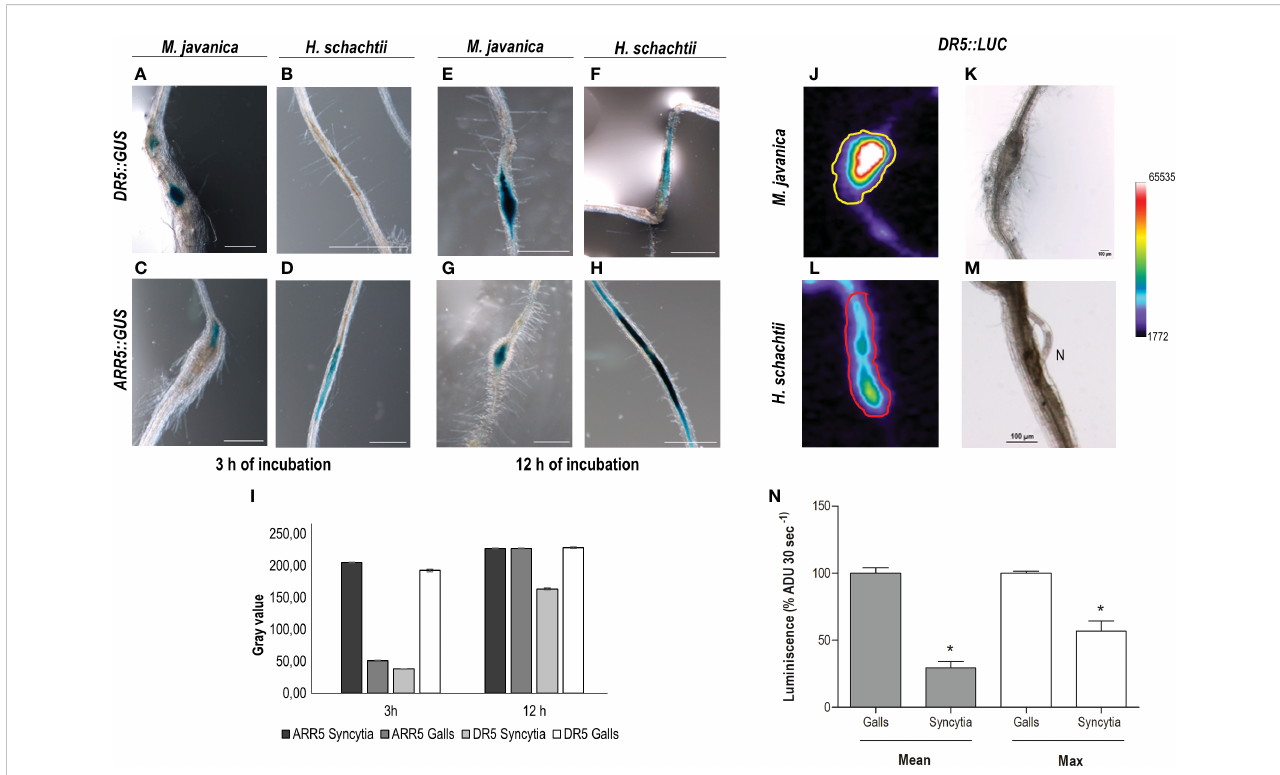
FIGURE 5 The auxin signaling pathway is more active in RKNs that in CN infection sites, while CN infection sites present a stronger cytokinin signaling pathway at early infection stages. Arabidopsis reporter lines DR5::GUS, DR5::Luciferase (DR5::LUC) and ARR5::GUS were inoculated with M. javanica (A, C, E, G, J, K) and with H. schachtii (B, D, F, H, L, M) , and at 3 – 4 days post infection (dpi) GUS or LUC were assayed. DR5::GUS signal in RKNs (A, E) and in CN infection sites (B, F) 3 and 12 h after incubation in the GUS reaction. GUS-staining of the ARR5::GUS 3 and 12 h after incubation in the GUS reaction in CN (D, H) and RKN (C, G) infection sites. Semiquanti fi cation of GUS histochemical staining in both infection sites of DR5::GUS and ARR5::GUS lines, after 3 or 12 h incubation (n ≥ 15 for each RKN or CN infection sites; (I) . Scale bars: 500 μm (A – H) . At least three independent experiments per independent line assayed were performed. DR5::LUC images of RKNs and CNs and infection sites ( J, L , respectively) and their corresponding transmission images (K, M) . Quanti fi cation of the luminescence (average signal per pixel in de fi ned Regions of Interest (ROIs), de fi ned in Supplementary Figure 4, relative to that of galls, N ) (N ≥ 15 CN and RKN infection sites; p <0.05). *Asterisk, signi fi cant differences; p <0.05; Student ’ s t-test). ADU, analogical digital units. Pseudocoloring scale is indicated. Two independent experiments were